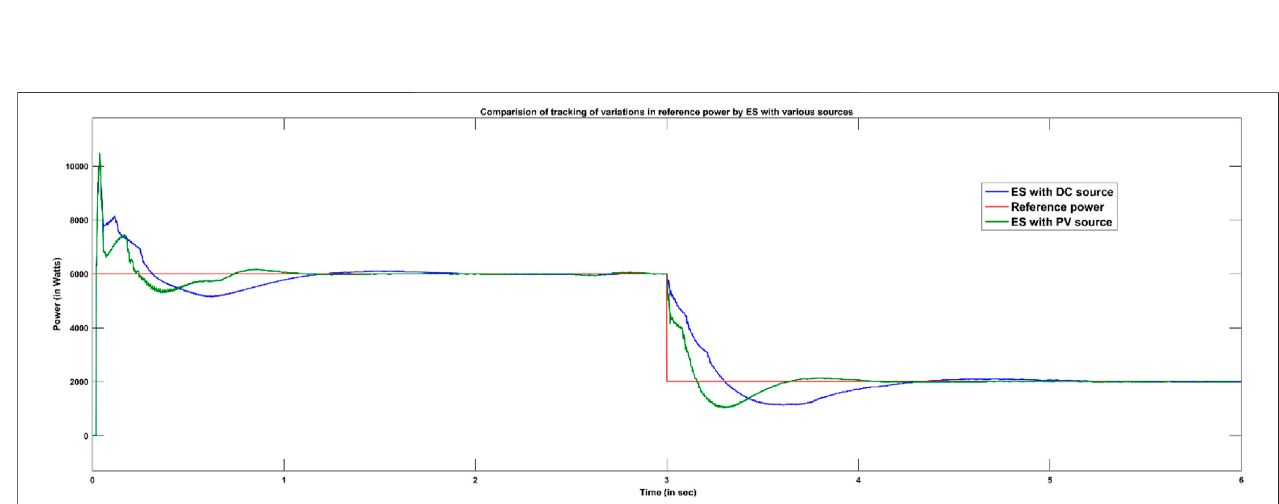
FIGURE 11 | Comparison of tracking variations in reference power.